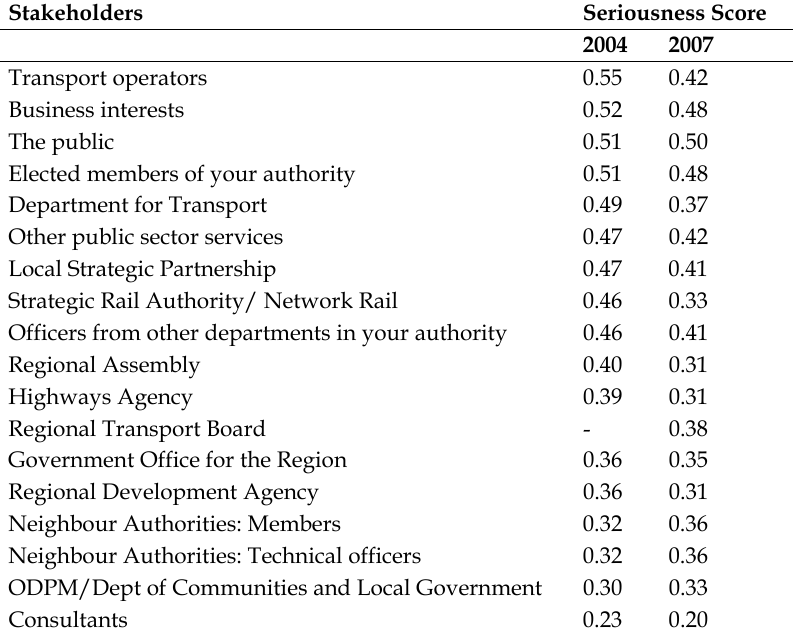
Table 5. Involvement of stakeholders in the overall transport strategy and scheme delivery